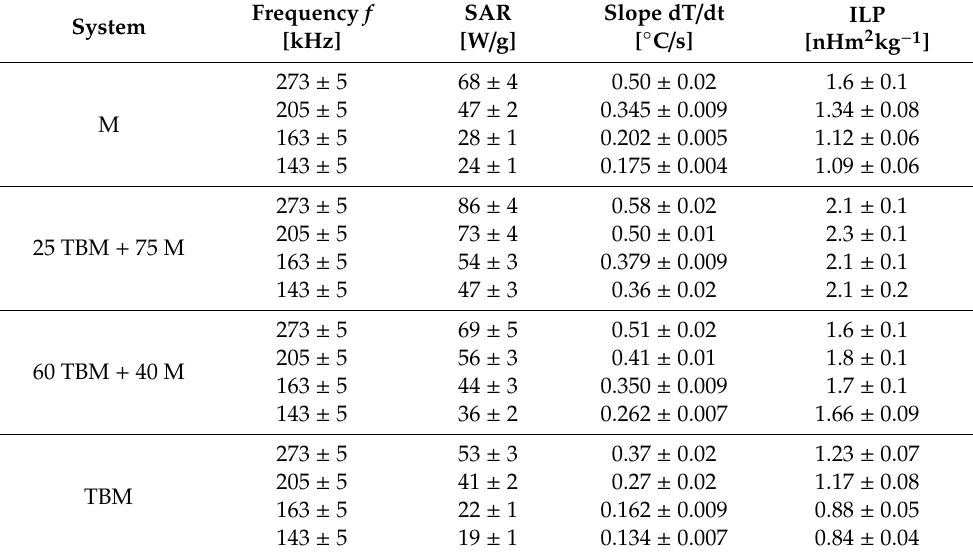
Figure 3. Time evolution of the temperature of the different nanoparticles suspensions, for different frequencies. Magnetic field strength: H 0 = 12.5 kA/m. Sample volume 0.5 mL; particle concentration: 30 mg/mL. Table 1. Summary of SAR and ILP calculations at different frequencies with a fixed magnetic field intensity of 12.5 kA/m.